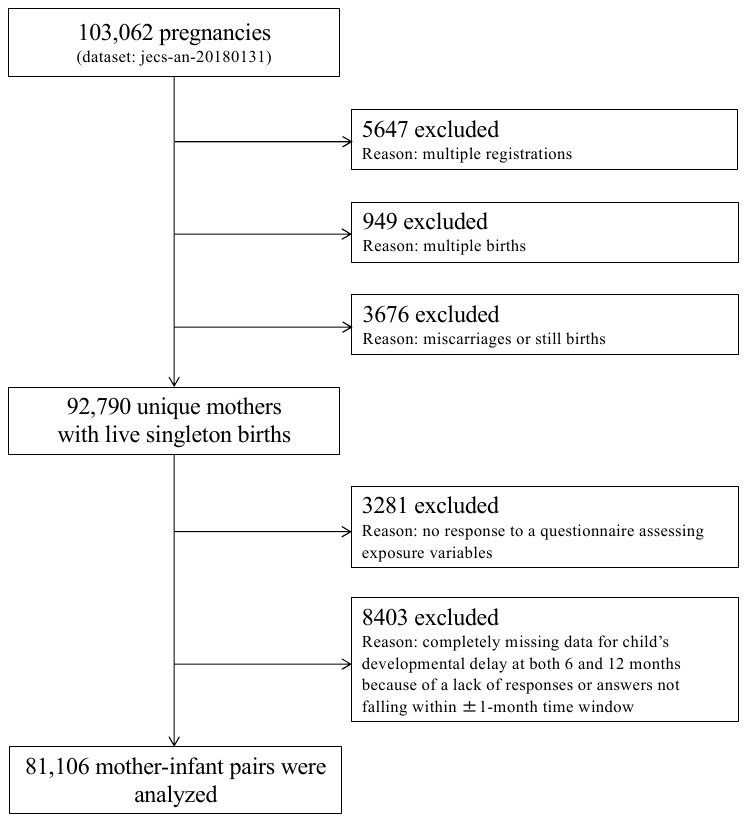
Figure 1. Study flow chart.